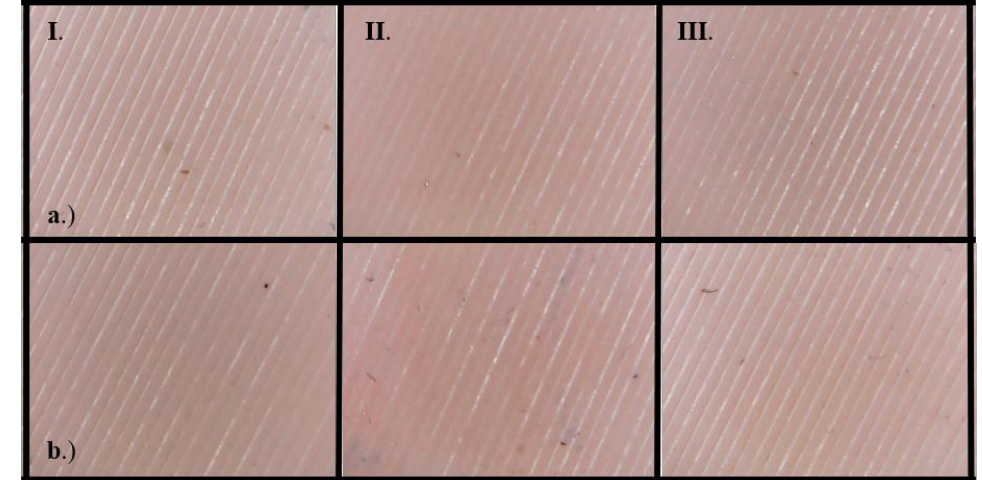
Figure 4. Results of flex resistance test of ZA-22 silicone. The numbers of the column refer to the number of disinfection cycles (I: non-disinfected, II: 5 cycles of disinfection, III: 10 cycles of disinfection). Row ( a ) marks the test specimens after 1000 flex test cycles; row ( b ) marks the specimens after 5000 flex cycles.